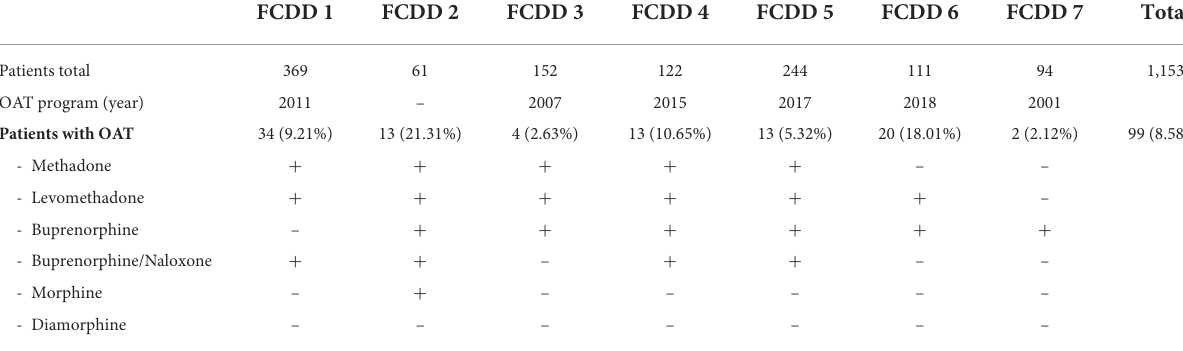
TABLE 2 Patient numbers and available OAT options in seven Forensic Clinics for Dependency Diseases in Germany in 2018.